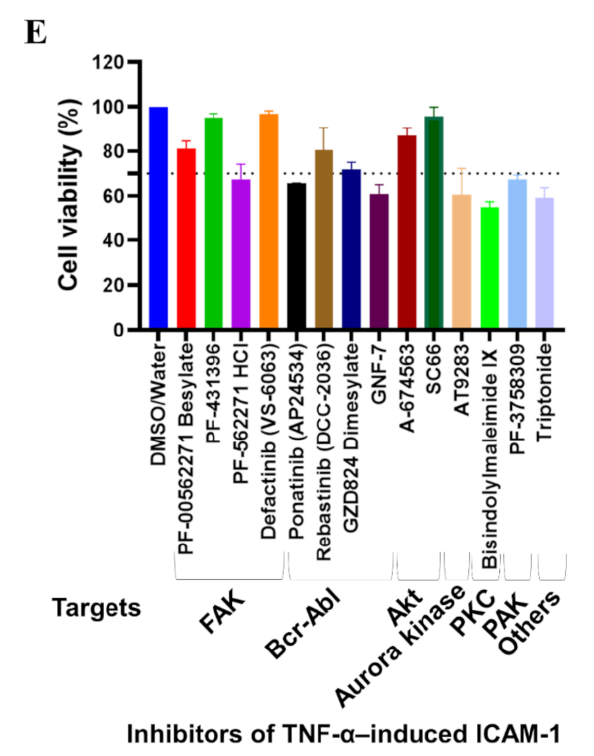
Figure 6. Screening of host cytoskeletal signaling compounds inhibiting VLPs-mediated endothelial cells activation ( A ) Illustration of the screening strategy. The screening was conducted on VLPs- or TNF- α -treated cells. Compounds ( n =179) were evaluated for their effects on the inhibition of ICAM-1 expression. The fluorescence corresponding to the expression of ICAM-1 was measured 12 and 48 h post-treatment for TNF- α - or VLPs-treated cells, respectively, following immunostaining. The protective effects of the compounds were assessed through nuclear staining and imaging. RevitaCell Supplement was used as the positive control. Compounds exhibiting 70% inhibition of ICAM-1 expression were considered effective inhibitors, with 28 and 14 of them inhibiting VLPs- and TNF- α -induced ICAM-1 expression, respectively. ( B ) The target host proteins for VLPs-induced ICAM-1 inhibitors and ( C ) TNF- α -induced ICAM-1 inhibitors are shown. ( D ) The inhibitors of VLPs-induced ICAM-1 expression targeting FAK and ( E ) those of TNF- α -induced ICAM-1 expression targeting FAK, Akt, and Bcr-Abl showed less than 30% cytotoxicity (limit shown by grid lines at 70% cell